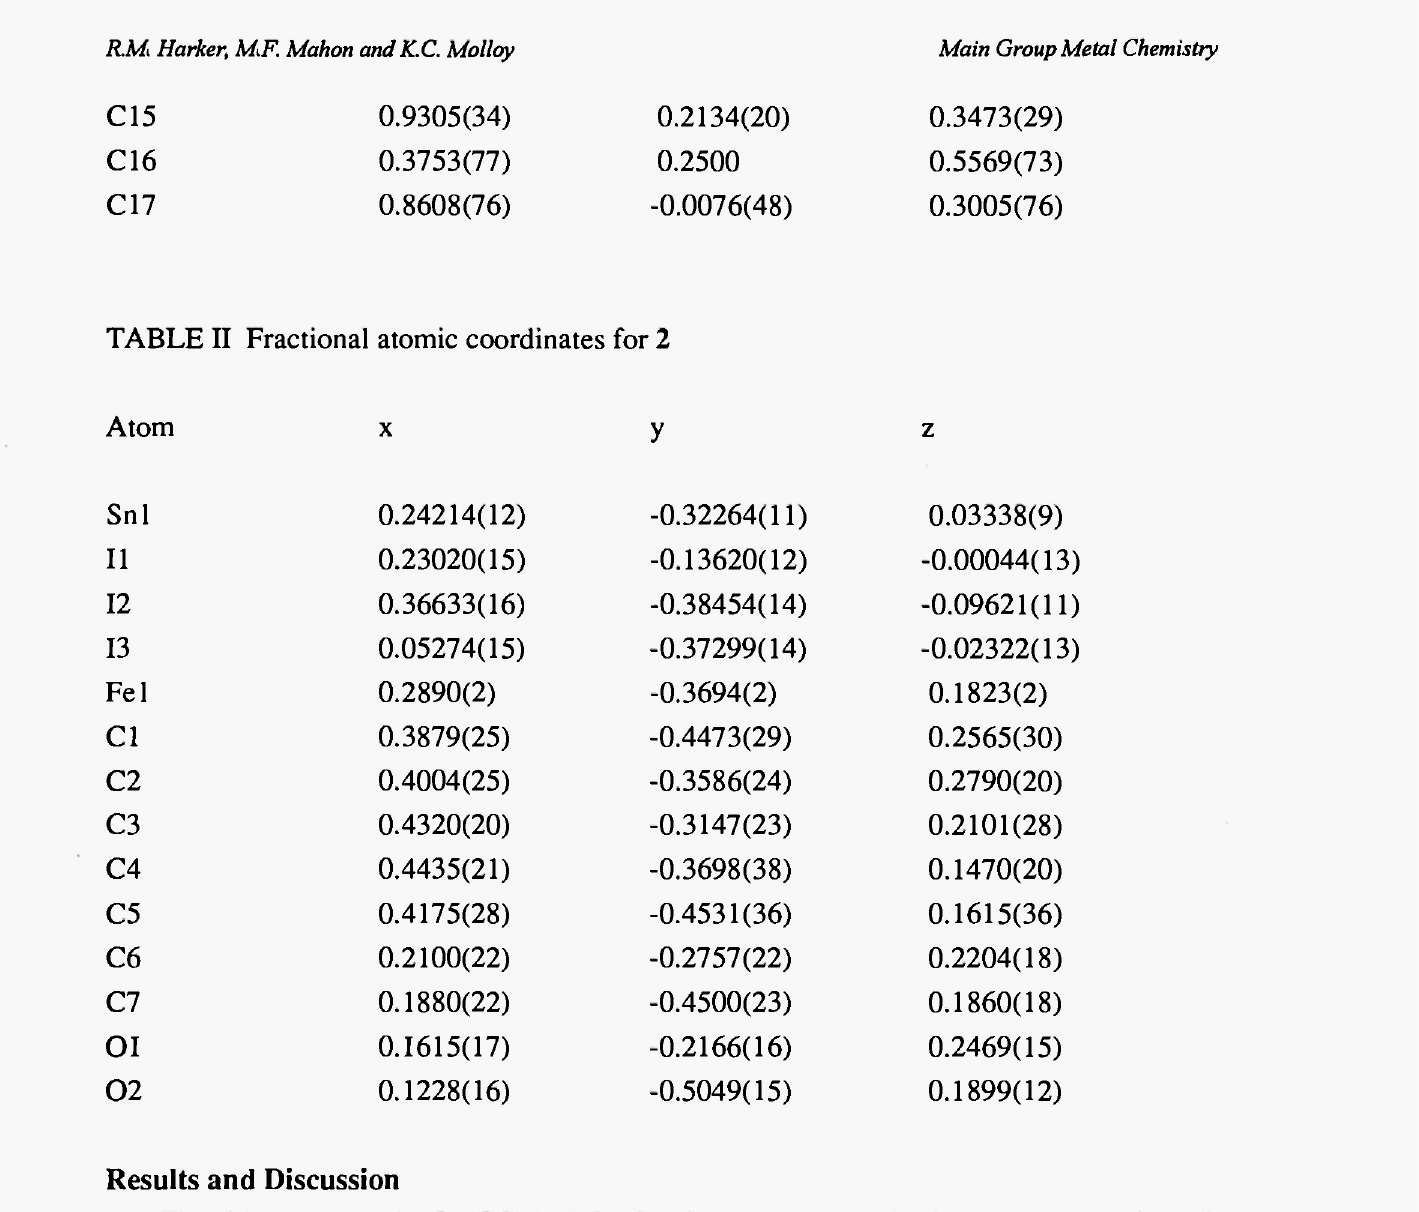
TABLE II Fractional atomic coordinates for